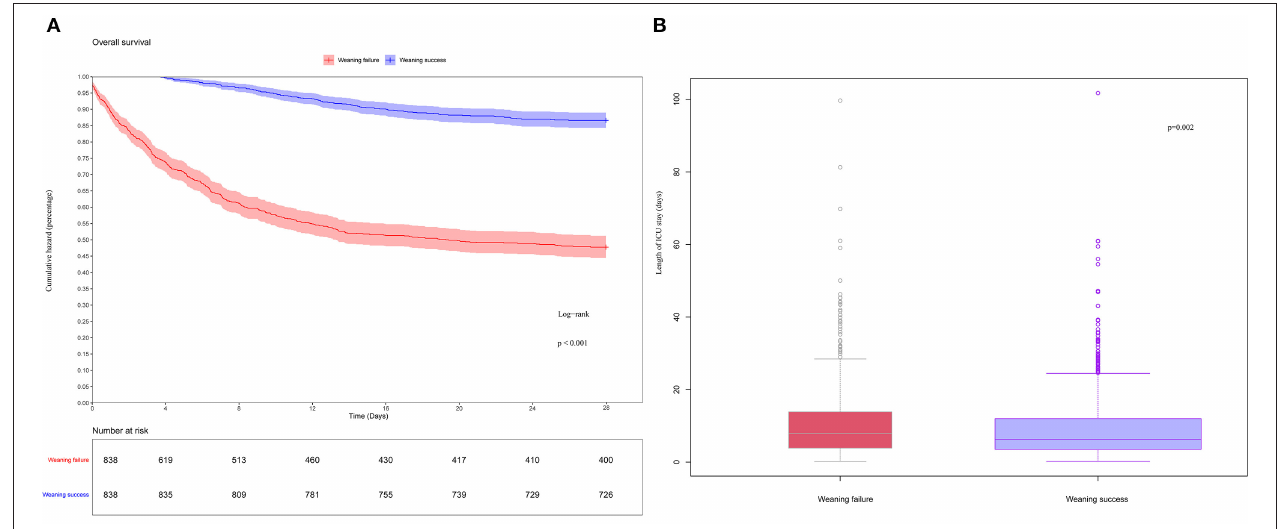
FIGURE 2 | (A) K-M curves estimated 28-day survival probability of weaning failure and weaning success patients. (B) Box-plot of weaning failure and weaning success